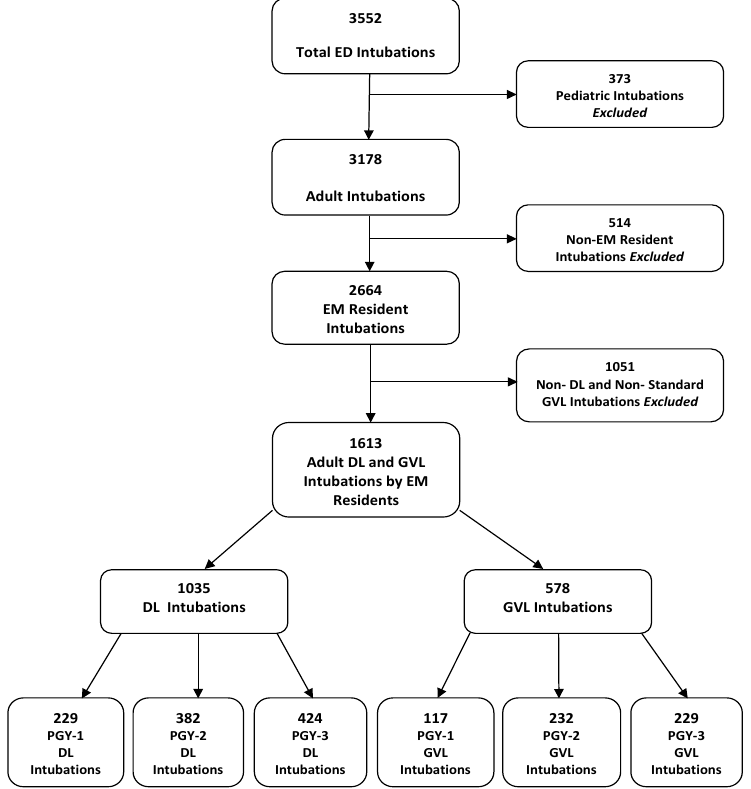
Figure 1. Flow diagram of patients in DL and GVL cohorts.